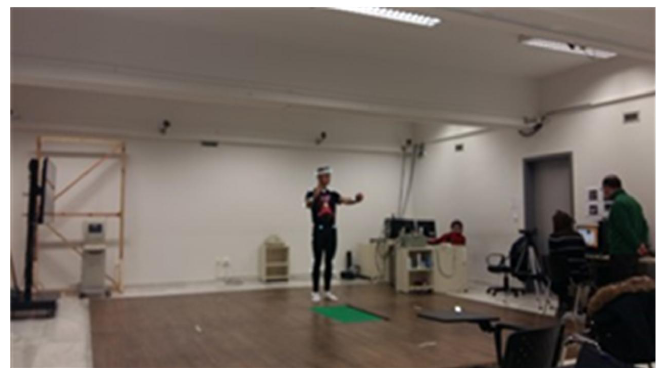
Figure 4. A snapshot from the experiments conducted at the Aristotle University of Thessaloniki for capturing the folklore dances.